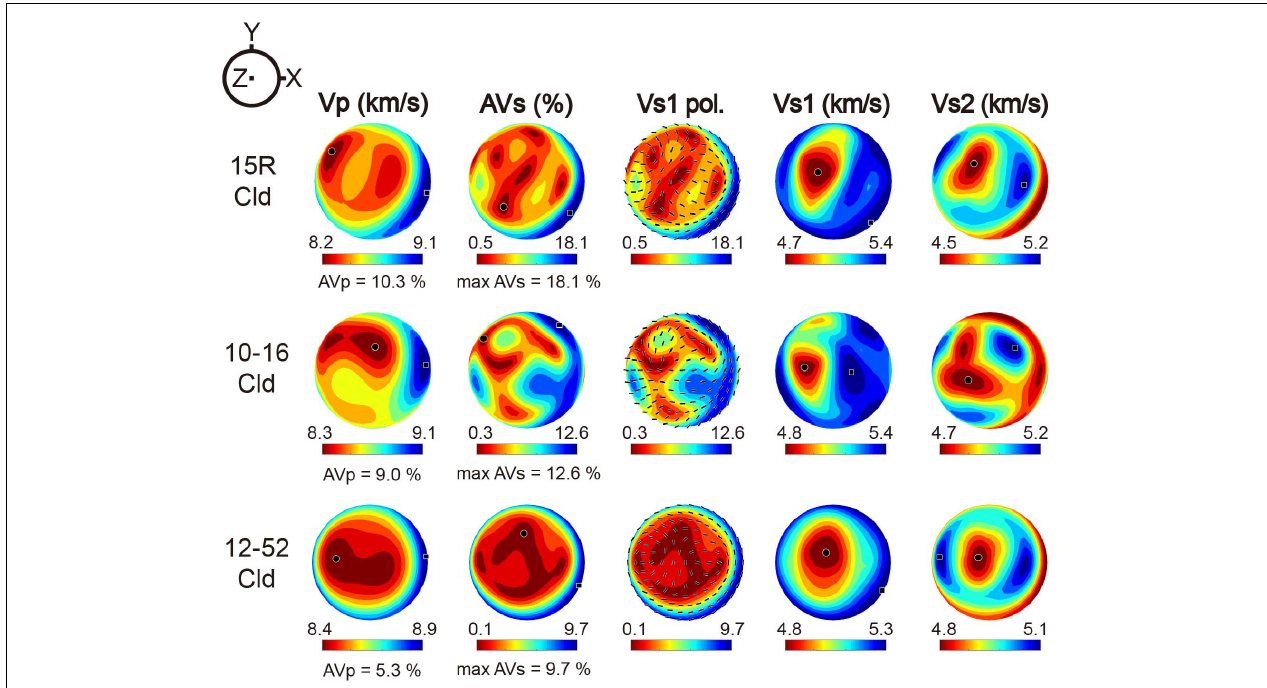
FIGURE 5 | Seismic anisotropies of polycrystalline chloritoid in the UHP Makbal schist samples. The elastic anisotropy using GGA method ( Figure 4 ) was applied to the calculation (see “Materials and Methods” section). The P-wave anisotropy is up to AV P = 10.3% (sample #15R), and the S-wave anisotropy is up to AV S = 18.1% (sample #15R). The anisotropy is shown on a stereonet, in which the center of a plot (Z) represents the direction normal to the foliation (X-Y plane), and X corresponds to the lineation. V P , P-wave velocity; AV S , shear wave anisotropy; V S1 pol, polarization direction of the fast S-wave; V S1 , fast S-wave velocity; V S2 , slow S-wave